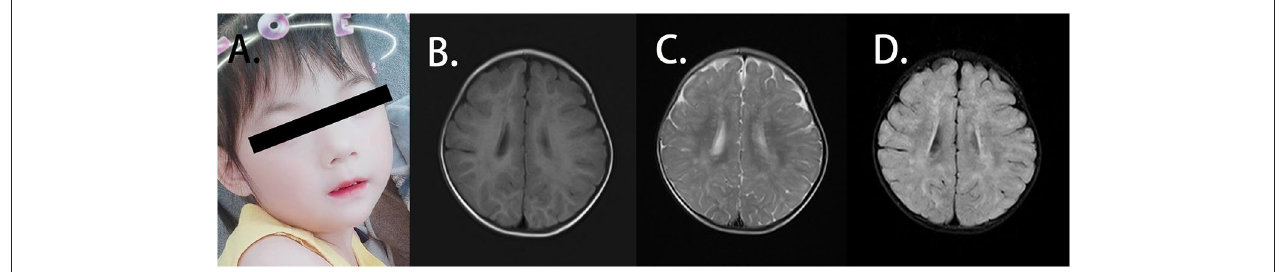
FIGURE 1 | Clinical features of the patient. (A) The patient presented with facial dysmorphic features with hypertelorism, long philtrum, and thin upper lip vermilion. (B) Axial T1W1 magnetic resonance imaging (MRI) of the patient displayed blotch and piece-like lesions with the prolonged signal. (C) Axial T2W1 MRI imaging of the patient showed the abnormal shades distributed in bilateral frontal, temporal, parietal, and occipital lobes and basal ganglia. (D) From axial FLAIR imaging, the abnormal lesion was identified mainly in the white matter, and strip-like signals can also be observed in the bilateral basal ganglia.